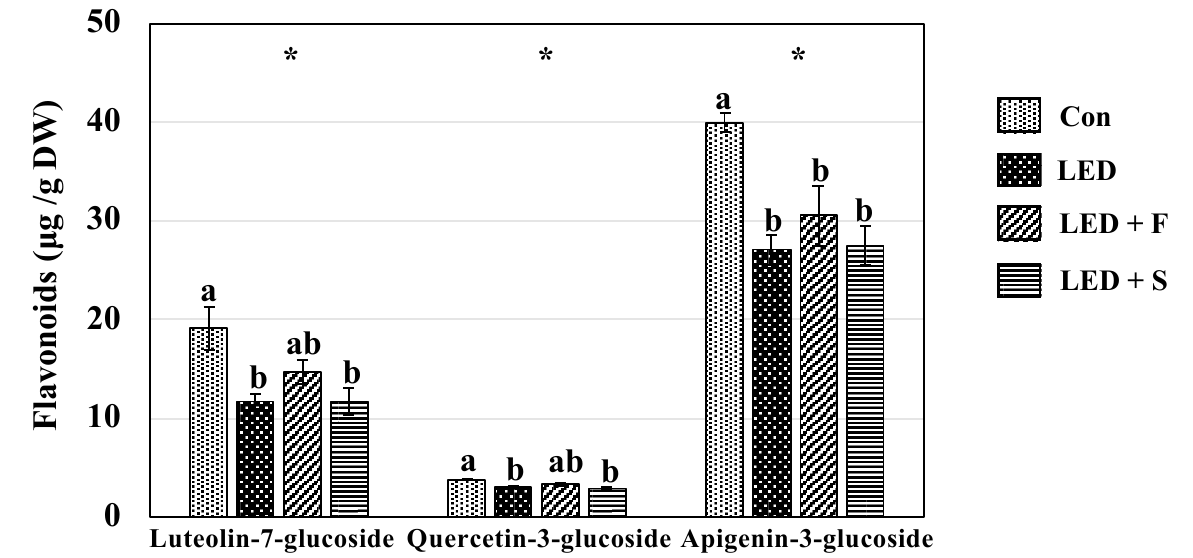
Figure 4. Concentrations of individual phenolic compounds in lettuce variety ‘New Red Fire’ sub- jected to supplemental UV-A radiation. Treatments included LEDs, LEDs + focus lens (LED + F), LEDs + scatter lens (LED + S), and control (Con). Measurements were made after 6 days of treatments. Vertical bars indicate standard errors (n = 4). Bars with different letters are significantly different. Significant differences are presented at p < 0.05 (*).